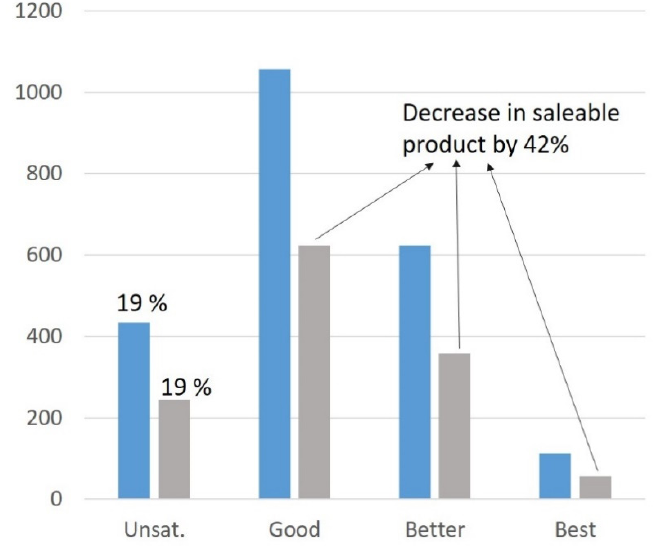
Figure 5. Number of samples in each quality category for grilles striploins (blue) and after applying threshold criteria (grey). The % failure is displayed above the fall column [32]. Threshold criteria are pH ( > 6), age ( > 30 months for females and steers, > 18 months for young bulls), conformation ( < 0 + ), fat score ( < 3), aging length ( < 7 days for females and steers; < 14 days for young